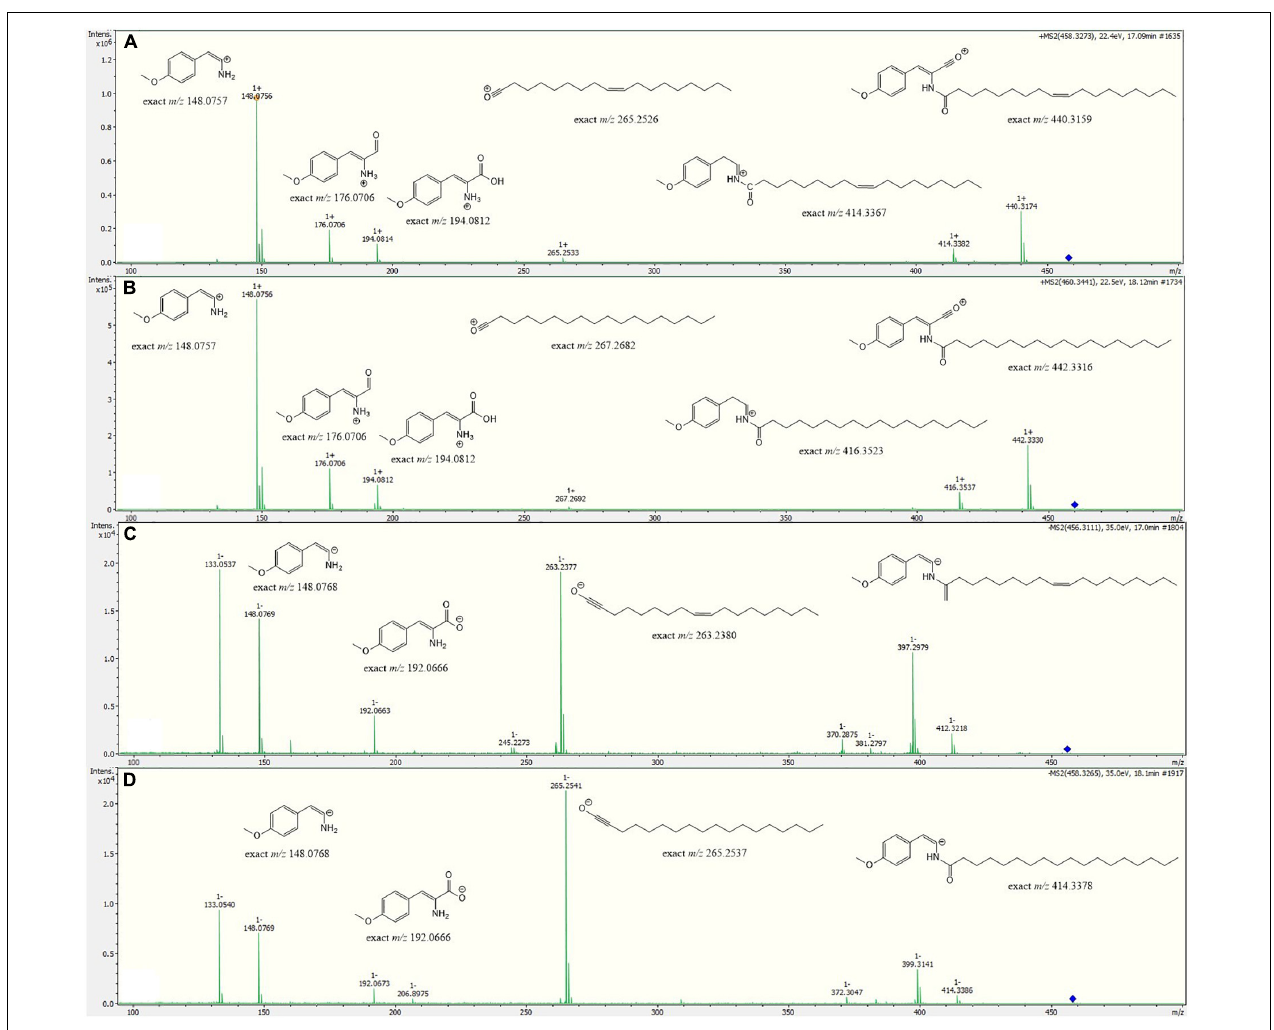
FIGURE 4 | HRESIMS/MS spectra of stieleriacine D ( 1 ) and E ( 2 ) in positive and negative modes with potential fragments. (A) 1 in positive mode (B) 2 in positive mode (C) 1 in negative mode (D) 2 in negative mode.